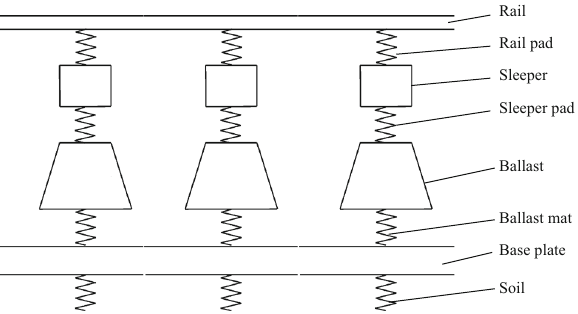
Fig. 2 Model of the track: multi-beam on support or multi-beam on